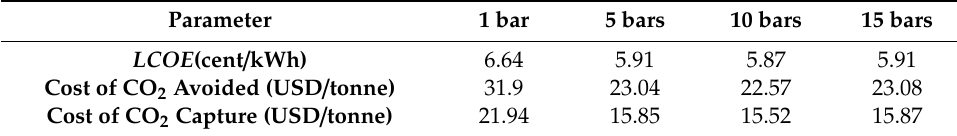
Table 6. Economic model results for oxy-petcoke plant at di ff erent pressures in the KSA.